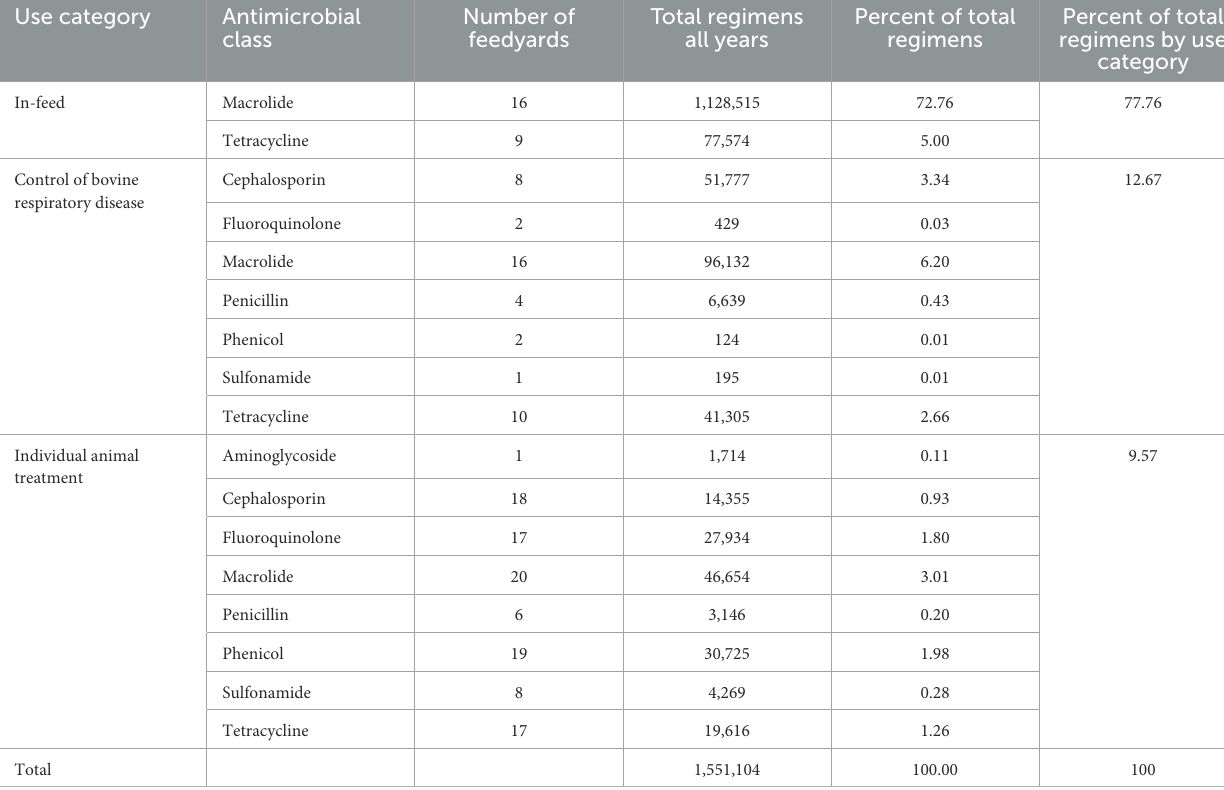
TABLE 3 Medically important regimens by antimicrobial class within use category (2018 and 2019